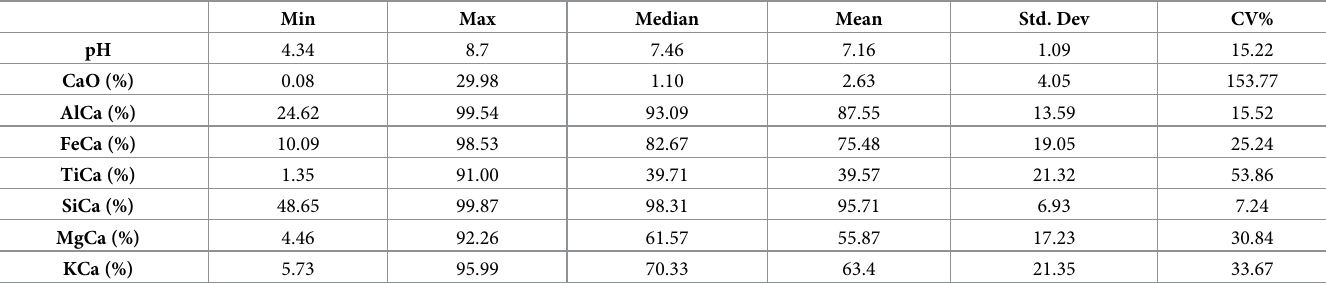
Table 2. Descriptive statistics of soil pH and geochemical indices (N = 1163).